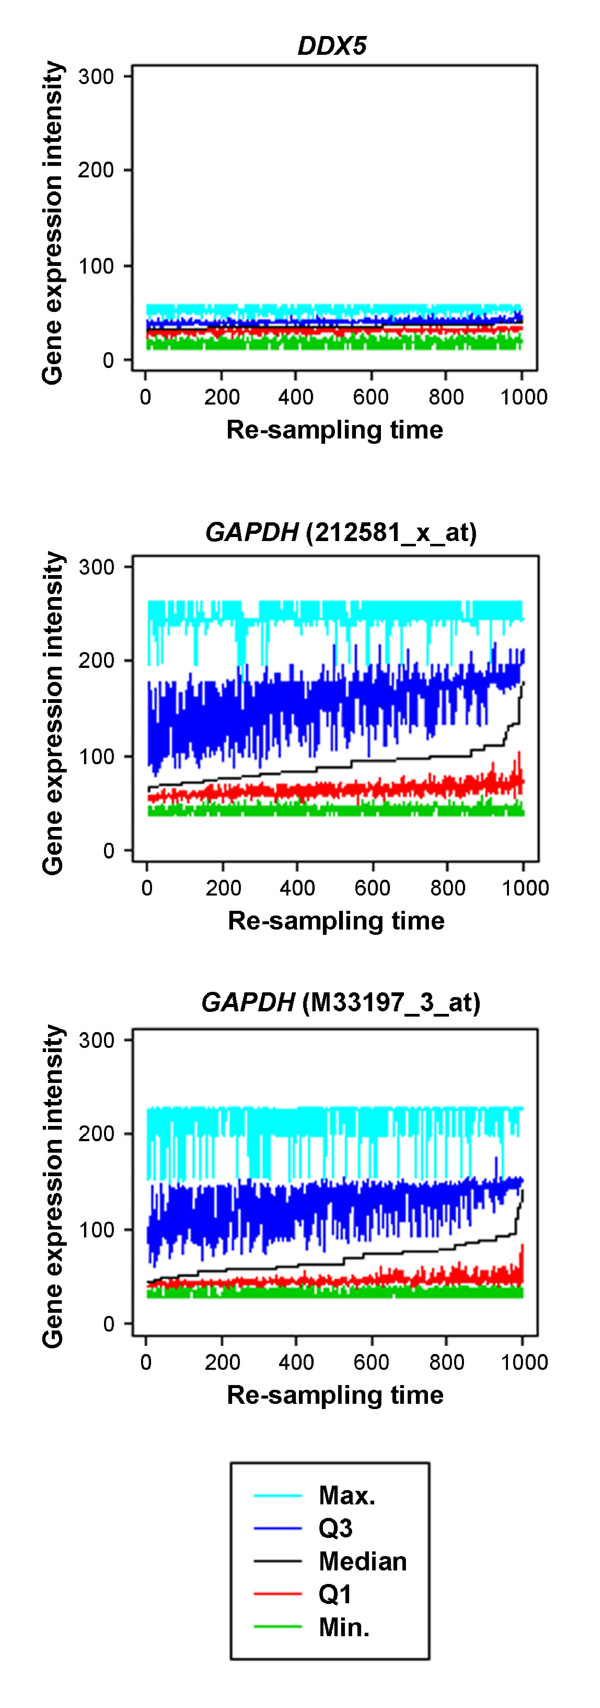
Bootstrap replicates of the descriptive statistics related to the variation in gene expression. In total, 27 pairs of adjacent normal and tumor samples with 12 un-paired samples were used in this analysis. A total of 39 blocks of microarray samples were used for the block bootstrap. The re-sampling process was repeated 1,000 times to obtain 1,000 bootstrap replicates of the minimum (green color), first quartile (red color), median (black color), third quartile (blue color) and maximum (cyan color) expression levels for each gene. Each result was ranked by the order of medians. The bootstrap replicates of all five statistics for DDX5 expression remain roughly constants, but those for GAPDH expression vary greatly.